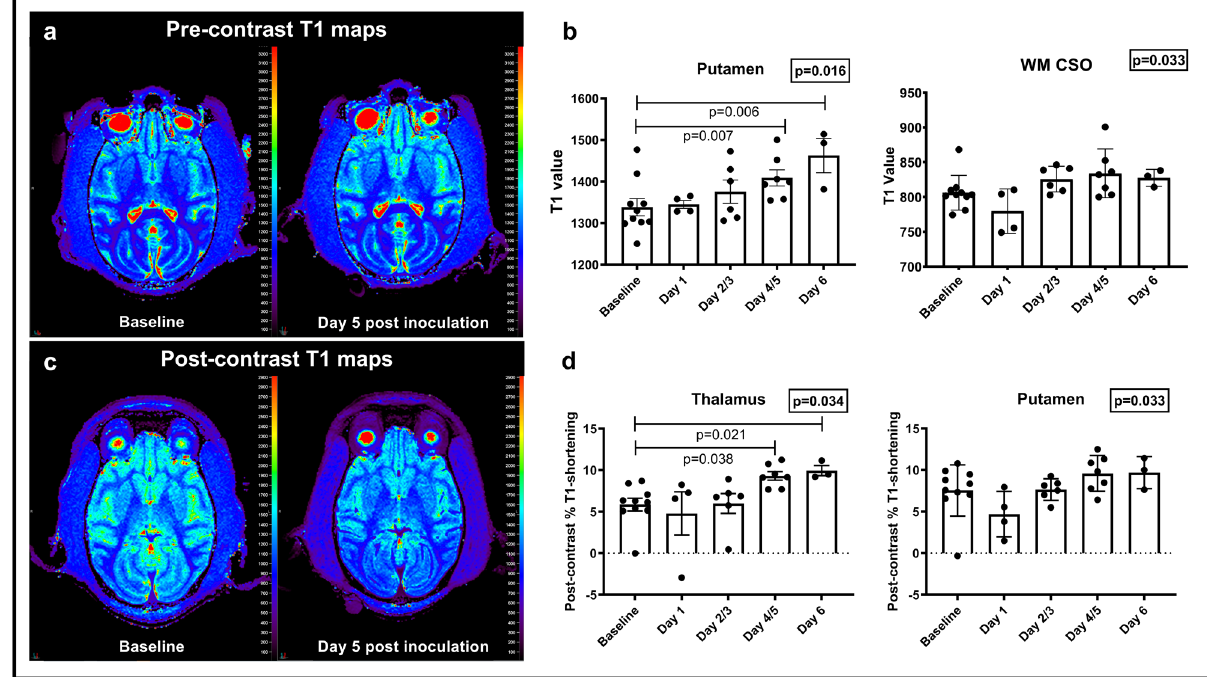
Fig. 2 Longitudinal T1-relaxometry changes in infected monkeys. a Qualitative T1 maps at baseline and on day 5 after inoculation in one representative animal show subtle increased T1 values especially in the basal ganglia. b Increases in T1 pre-contrast values are noted in the putamen and white matter centrum semiovale over the course of the disease ( n = 10 animals, Linear mixed effect model, S-plus 8.2). Data are presented as mean values + / − SEM. c Qualitative post contrast T1 maps in one representative animal show further decreased T1 values on day 5 after inoculation compared to baseline. d Increases in Post-contrast % T1-shortening in the putamen and thalamus over the course of disease ( n = 10 animals, Linear mixed effect model, S-plus 8.2). Data are presented as mean values + / − SEM. Source data are provided as a Source Data fi